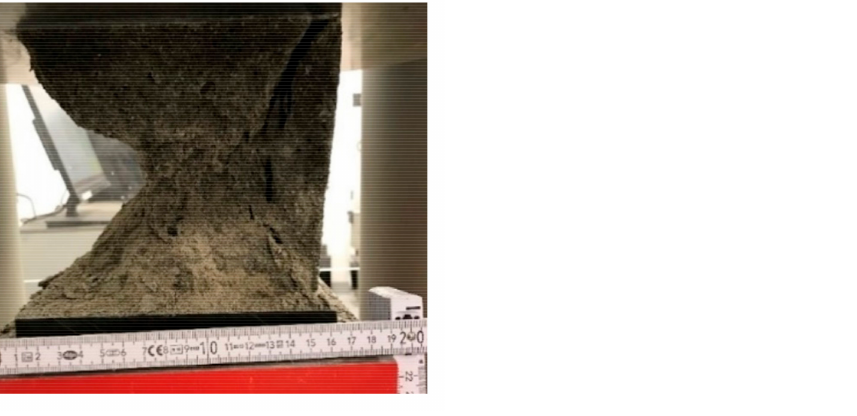
Figure 8. Destruction of sample with 1800 g/m 3 glass fiber addition in the compressive strength